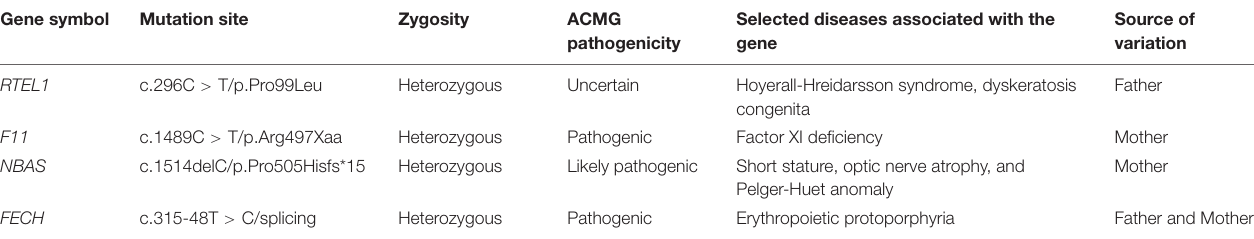
TABLE 2 | Potential pathogenic genetic variants detected in Patient